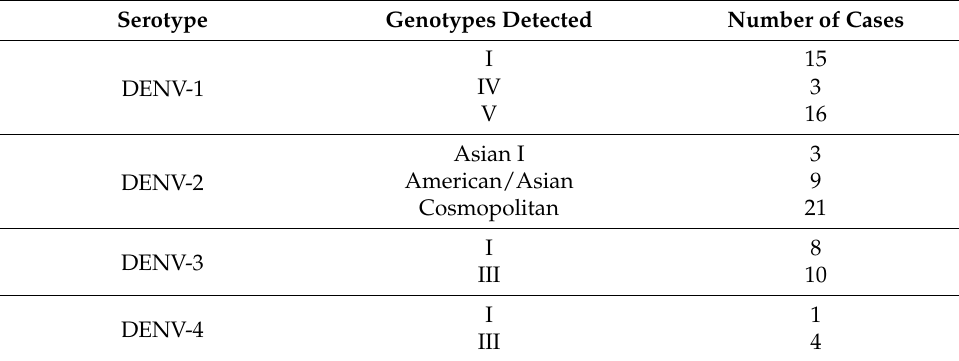
Table 2. DENV genotypes detected in travelers. Serotype Genotypes